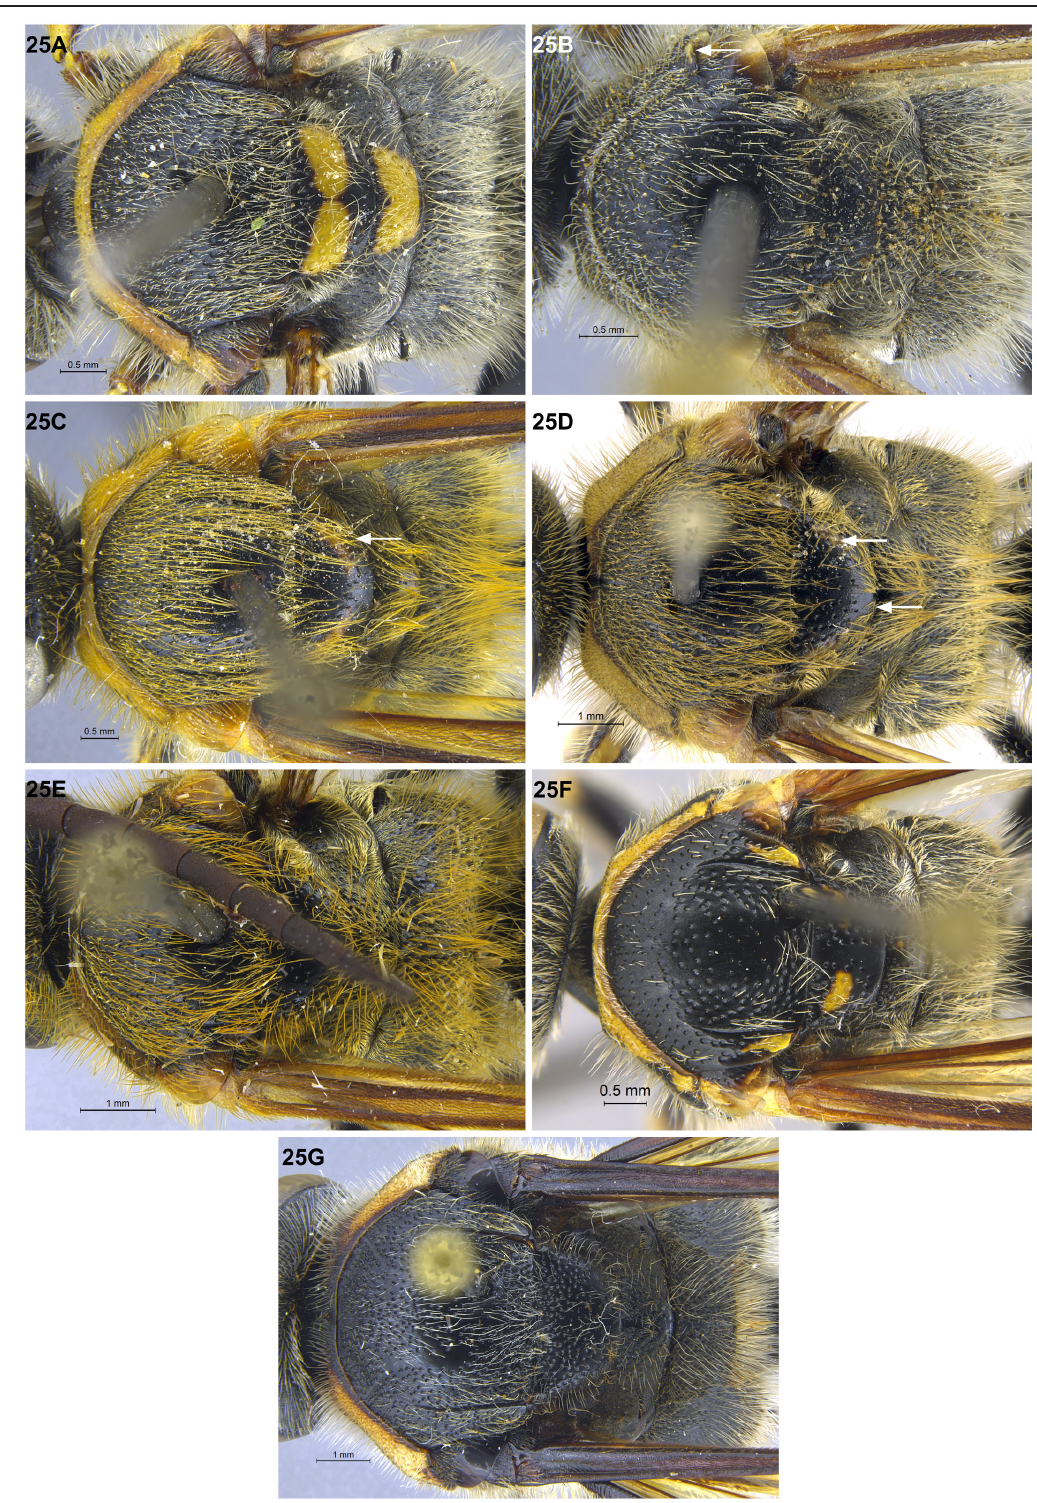
Fig. 25. Males, mesoscutum. A . Campsomeriella annulata annulata (Fabricius, 1793). B . Camps. collaris (Fabricius, 1775). C . Megacampsomeris sp. 1. D . Megacam. formosensis chinensis Betrem, 1941. E . Megacam. prismatica (Smith, 1855). F . Phalerimeris phalerata phalerata (de Saussure, 1858). G . Sericocampsomeris flavomaculata Gupta & Jonathan,